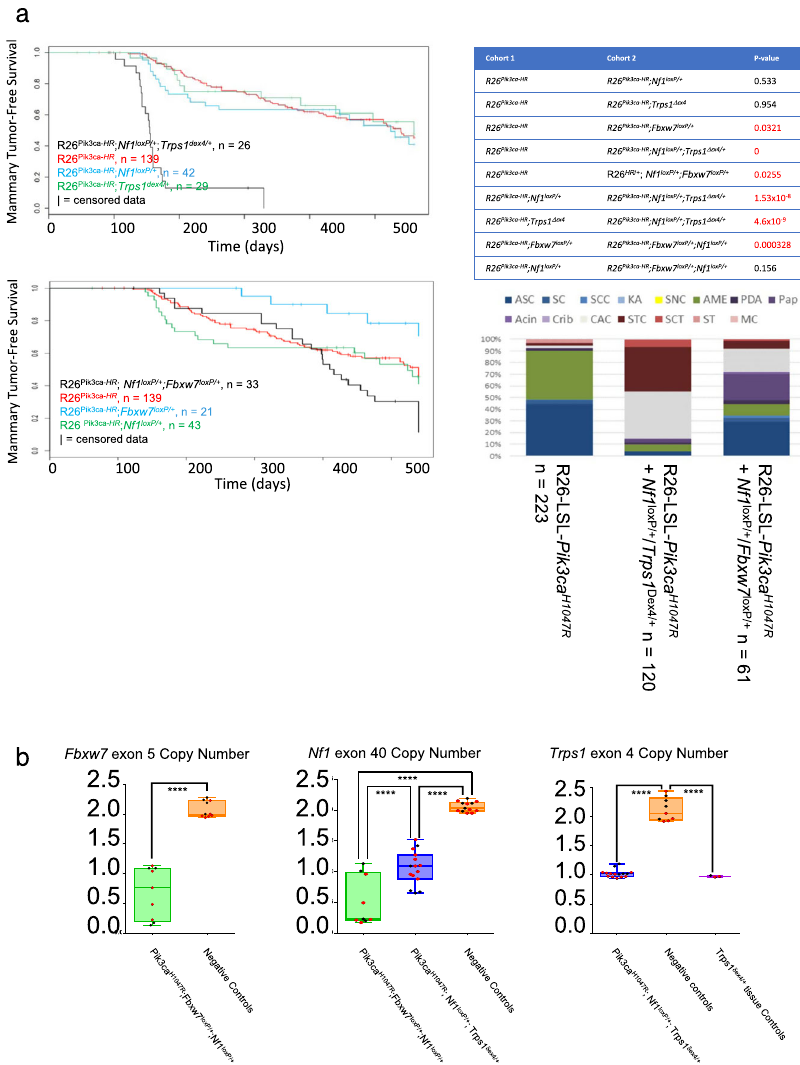
Fig. 8 SB mutagenesis identi fi es conditional haploinsuf fi cient tumor suppressor genes. a Kaplan – Meier survival analysis for mice expressing Pik3ca H1047R together with heterozygous mutations in Nf1 ( Nf1 loxP/ + ) and/or Trps1 ( Trps1 δ ex4/ + ), or neither gene (top). Kaplan – Meier survival analysis for mice expressing Pik3ca H1047R together with heterozygous mutations in Nf1 ( Nf1 loxP/ + ) and/or Fbxw7 ( Fbxw7 loxP/ + ), or neither gene (middle). Bar graphs show histology of tumors that form in Pik3ca H1047R or combined cohort mice. Mice in each cohort are also positive for MMTV-Cre NLST . R26 Pik3ca- HR